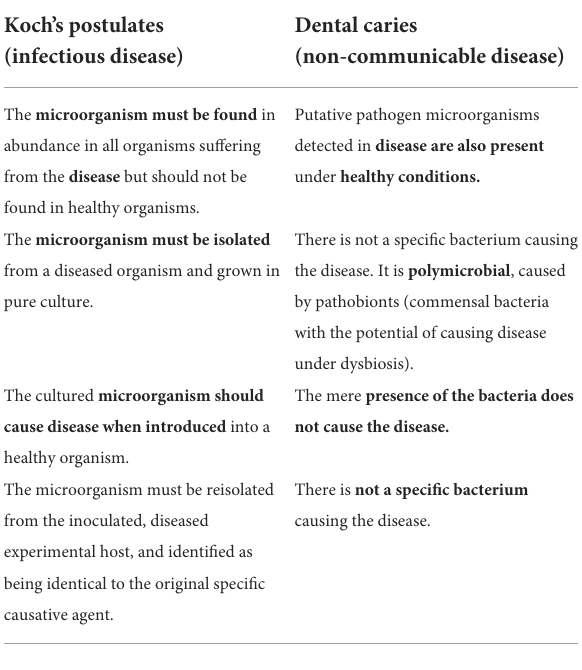
TABLE 1 Side-by-side comparison between Koch’s postulates [9] and dental caries, that shows why dental caries does not follow the pattern of canonical infectious